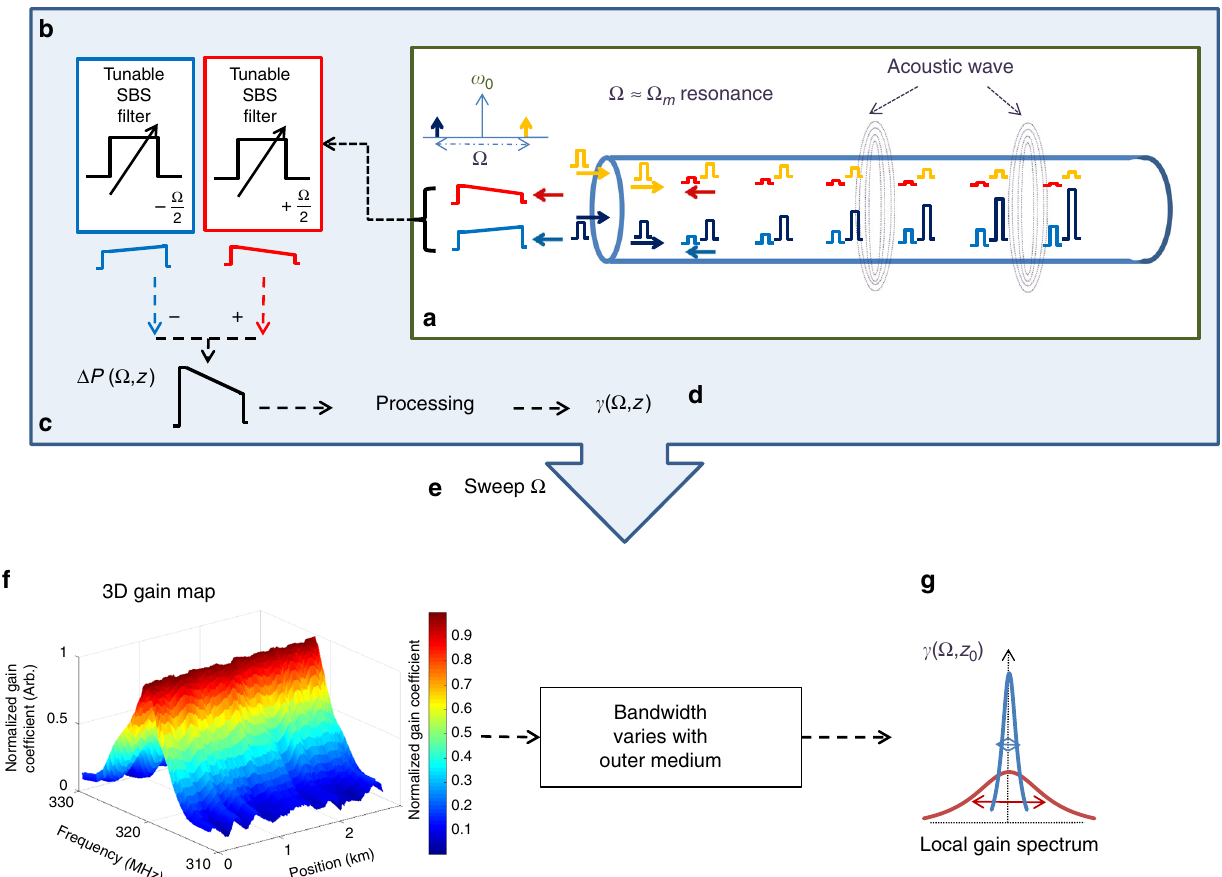
Fig. 1 The optomechanical time-domain re fl ectometry principle. Light at the input of a fi bre under test consists of two optical tones (marked yellow and Ω . The dark blue) within a common pulsed envelope ( a ). The two tones are detuned from a central optical frequency ω 0 by radio-frequency offsets ± 1 2 difference in frequencies Ω is chosen near the resonance frequency Ω m of the stimulation of a particular guided acoustic mode of the fi bre R 0, m . The two pulsed tones are launched into a fi bre under test (yellow and dark blue pulses, propagating left to right). The stimulation of acoustic waves along the fi bre under test is accompanied by the coupling of optical power between the two tones: the lower-frequency pulses (dark blue) are ampli fi ed whereas the higher-frequency ones are attenuated (yellow). The exchange of power is monitored based on the Rayleigh backscatter of the two fi eld components (red and light blue). The two backscatter contributions are separated by narrowband, backwards stimulated Brillouin scattering (SBS) ampli fi ers ( b ). The waveforms are then detected and sampled for further of fl ine processing. The difference between the two backscatter traces Δ P ( Ω , z ) ( c ) is used to calculate the nonlinear optomechanical coef fi cient γ ( m ) ( Ω , z ), as a function of position z , for the particular choice of Ω ( d ). The measurement sequence is repeated for multiple values of radio-frequency offsets Ω ( e ), to reconstruct a three-dimensional map of optomechanical coupling as a function of both position and frequency ( f ). A cross-section of that map describes the local spectrum of the optomechanical coef fi cient γ z γ ( m ) ( Ω , z fi bre ( m ) ( Ω , z 0 ) at location 0 ( g ). The optomechanical coupling spectrum 0 ) varies with the mechanical impedance of the medium outside the at z 0 . The spectrum is narrow with a sharp peak for an uncoated section of fi bre in air (illustrated in blue curve). It becomes broader when the same section is immersed in liquid (red estimated instead based on the Rayleigh backscatter of the two fi eld components. Multi-wavelength analysis of Rayleigh back- scatter was previously proposed and employed in the distributed monitoring of four-wave mixing processes related to the Kerr effect, and in measurements of local chromatic dispersion 51,52 . A